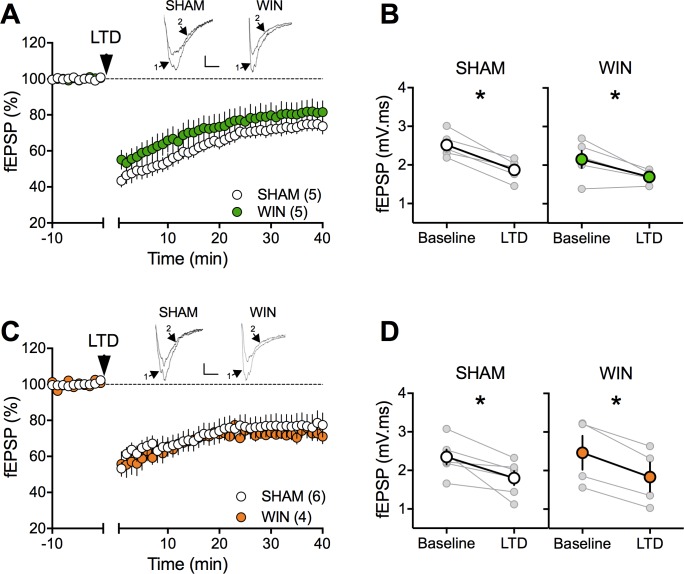
Prenatal cannabinoid exposure does not modify LTD in NAc of adult rats.(A) Average time-courses of mean fEPSPs showing that low-frequency stimulation (indicated by arrow) induces LTD at accumbens synapses in both SHAM- (white circles, n = 5) and WIN- (green circles, n = 5) exposed male rats. Above: example traces, baseline (1) and 40 min poststimulation (2). (B) Individual experiments (grey) and group average (tan), before (baseline) and after (40 min) LTD induction showing that PCE does not affect eCB-LTD in male accumbens. In SHAM male rats: 2.518 ± 0.145 mV.ms before LTD versus 1.872 ± 0.124 mV.ms after LTD induction (n = 5, p<0.05, paired t-test). In WIN male: 2.152 ± 0.224 mV.ms before LTD versus 1.696 ± 0.073 mV.ms after LTD induction (n = 5, p<0.05, paired t-test). (C) Average time-courses of mean EPSPs showing similar low-frequency LTD in SHAM (n = 6; white circles) and WIN (n = 4; orange circles) in utero-exposed female rats. Above: example traces, baseline (1) and 40 min poststimulation (2). (D) Individual experiments (grey) and group average (white represents SHAM; orange represents WIN), before (baseline) and after (40 min) LTD induction showing that prenatal WIN exposure does not alter LTD in the female exposed group. In SHAM female: 2.350 ± 0.191 mV.ms before LTD versus 1.800 ± 0.182 mV.ms after LTD induction (n = 6, p<0.05, paired t-test). In WIN female: 2.461 ± 0.439 mV.ms before LTD versus 1.833 ± 0.381 mV.ms after LTD induction (n = 4, p<0.05, paired t-test). n = individual rats. Error bars indicate SEM. Scale bar: 10 ms, 0.1 mV.